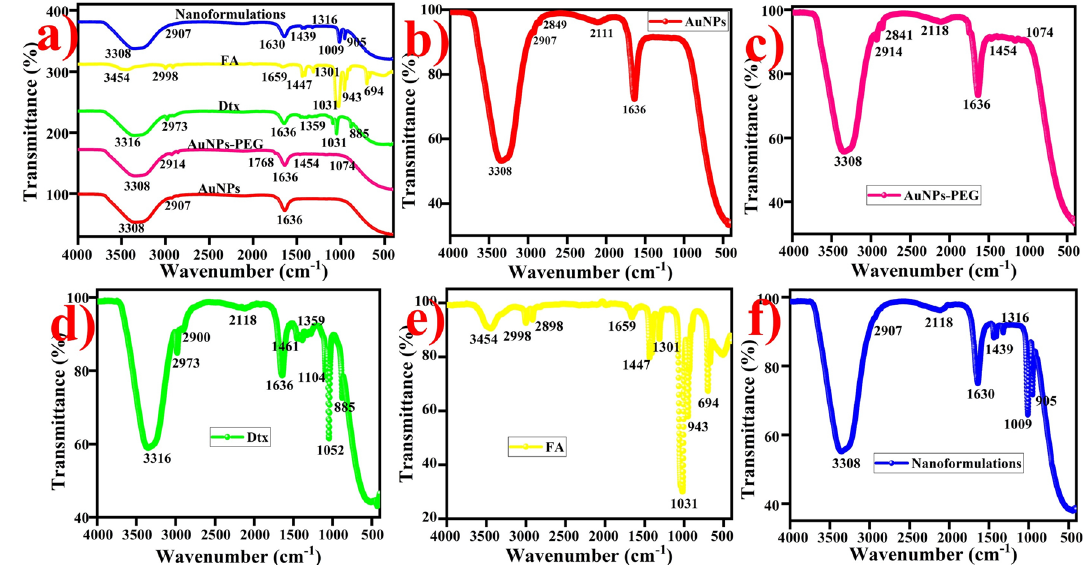
Figure 3. FTIR spectra of gold nanoformulations, ( a ) combined spectra of nanoformulations, ( b ) AuNPs, ( c ) AuNPs-PEG ( d ) Dtx, ( e ) FA and ( f ) AuNPs nanoformulations (AuNPs-PEG-FA-Dtx).